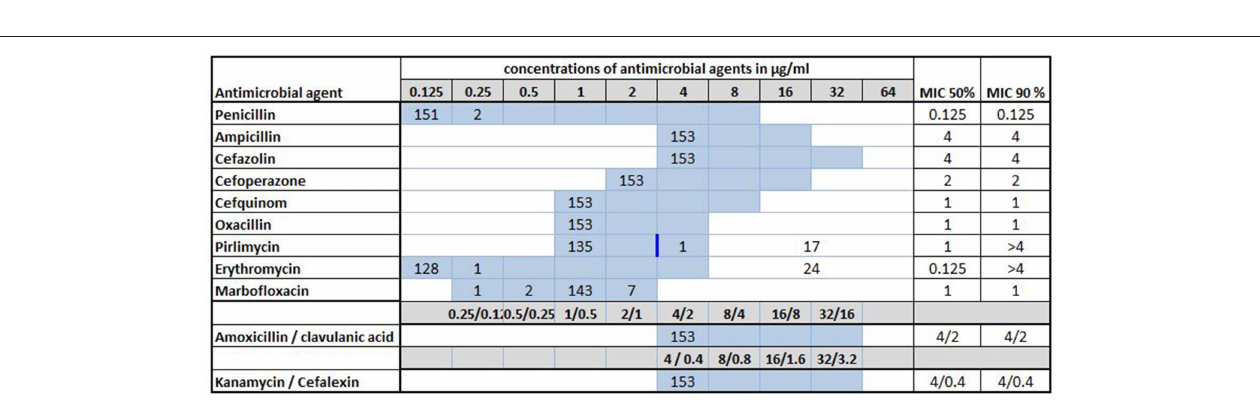
FIGURE 3 | Minimal inhibitory concentrations (MICs) of 11 antimicrobial agents for 153 Streptococcus uberis isolated from bovine mastitis milk during 2017 in Switzerland. Numbers indicate the number of strains exhibiting the corresponding MIC value. Light blue areas represent the tested concentration range on the microdilution plate. Values above this range denote MIC values greater than the highest concentration tested. The breakpoint ( ≥ 4 µ g/ml) for pirlimycin is indicated by a blue vertical bar. MIC 50 and MIC 90 values represent the concentrations of antimicrobial agents inhibiting growth of 50 or 90% of the strains, respectively.